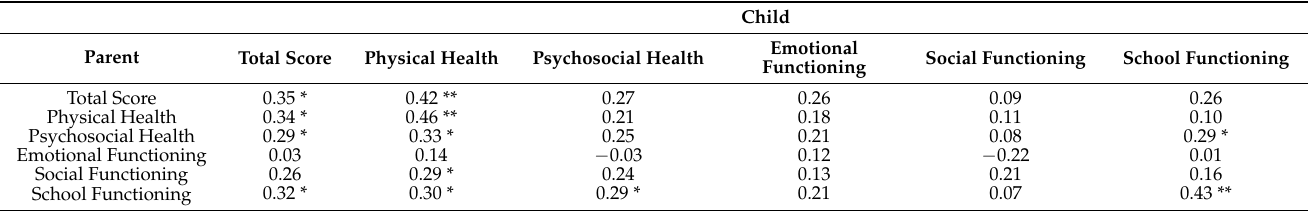
Table 3. Spearman correlations between the child’s (6–7 years) (n = 51) and the parent proxy-report of HRQoL.